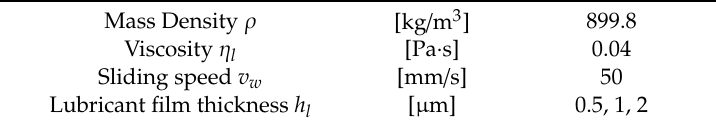
Table 5. Analytical conditions for the fluid-flow